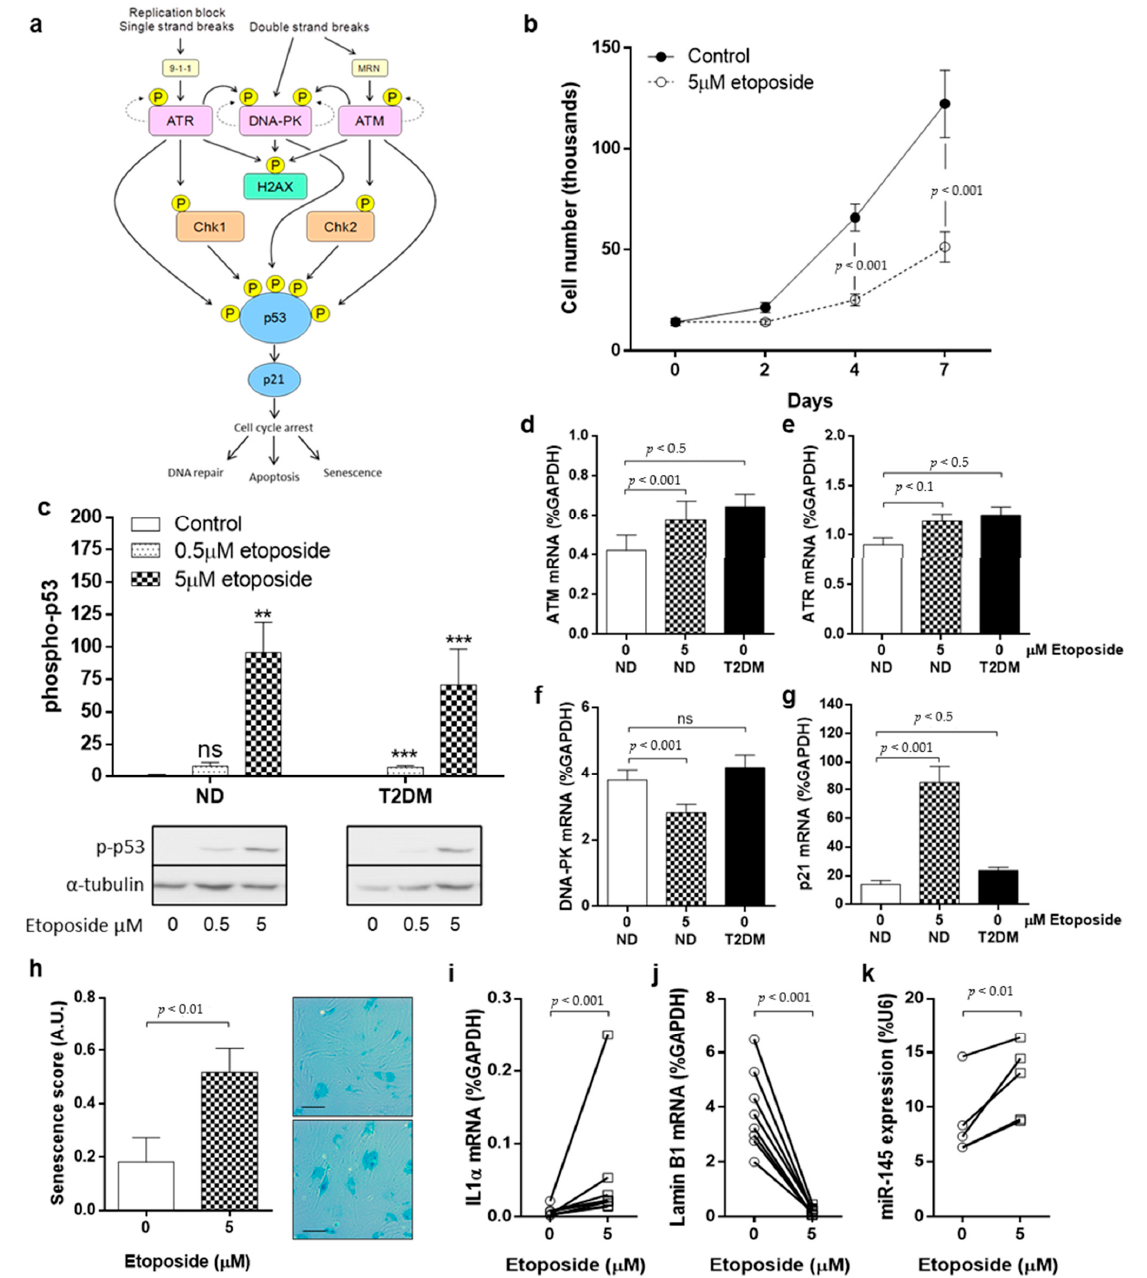
Figure 2. DNA damage drives a senescent SMC phenotype. ( a ) The DNA damage signalling pathway leading to phos- phorylation of p53, and subsequent downstream effects. ( b ) SMC were treated with DNA-damaging agent etoposide (5 μ M) or vehicle control (DMSO) for up to 7 days and proliferation quantified by cell counting ( n = 7). ( c ) The impact of etoposide on p53 phosphorylation was monitored using Western blotting after 24 h ( n = 4). ( d ) The effect of DNA damage on apical kinase expression was explored in ND-SMC that were treated with 5 μ M etoposide for 24 h. The expression of ATM , ( e ) ATR , ( f ) DNA-PK and ( g ) p21 was quantified using RT-PCR. The expression of these kinases was also measured in untreated T2DM-SMC to determine whether DNA damage per se could mimic a T2DM-SMC phenotype (all n = 8). ( h ) Cells were treated with etoposide for 24 h and then placed into FGM for 72 h. Cells were stained with SA- β -galactosidase (scale bar = 100 μ m). ( i ) The influence of etoposide on expression of IL-1 α , ( j ) LMNB1 (both n = 8) and ( k ) miRNA-145 expression ( n = 6–8) was quantified using RT-PCR.